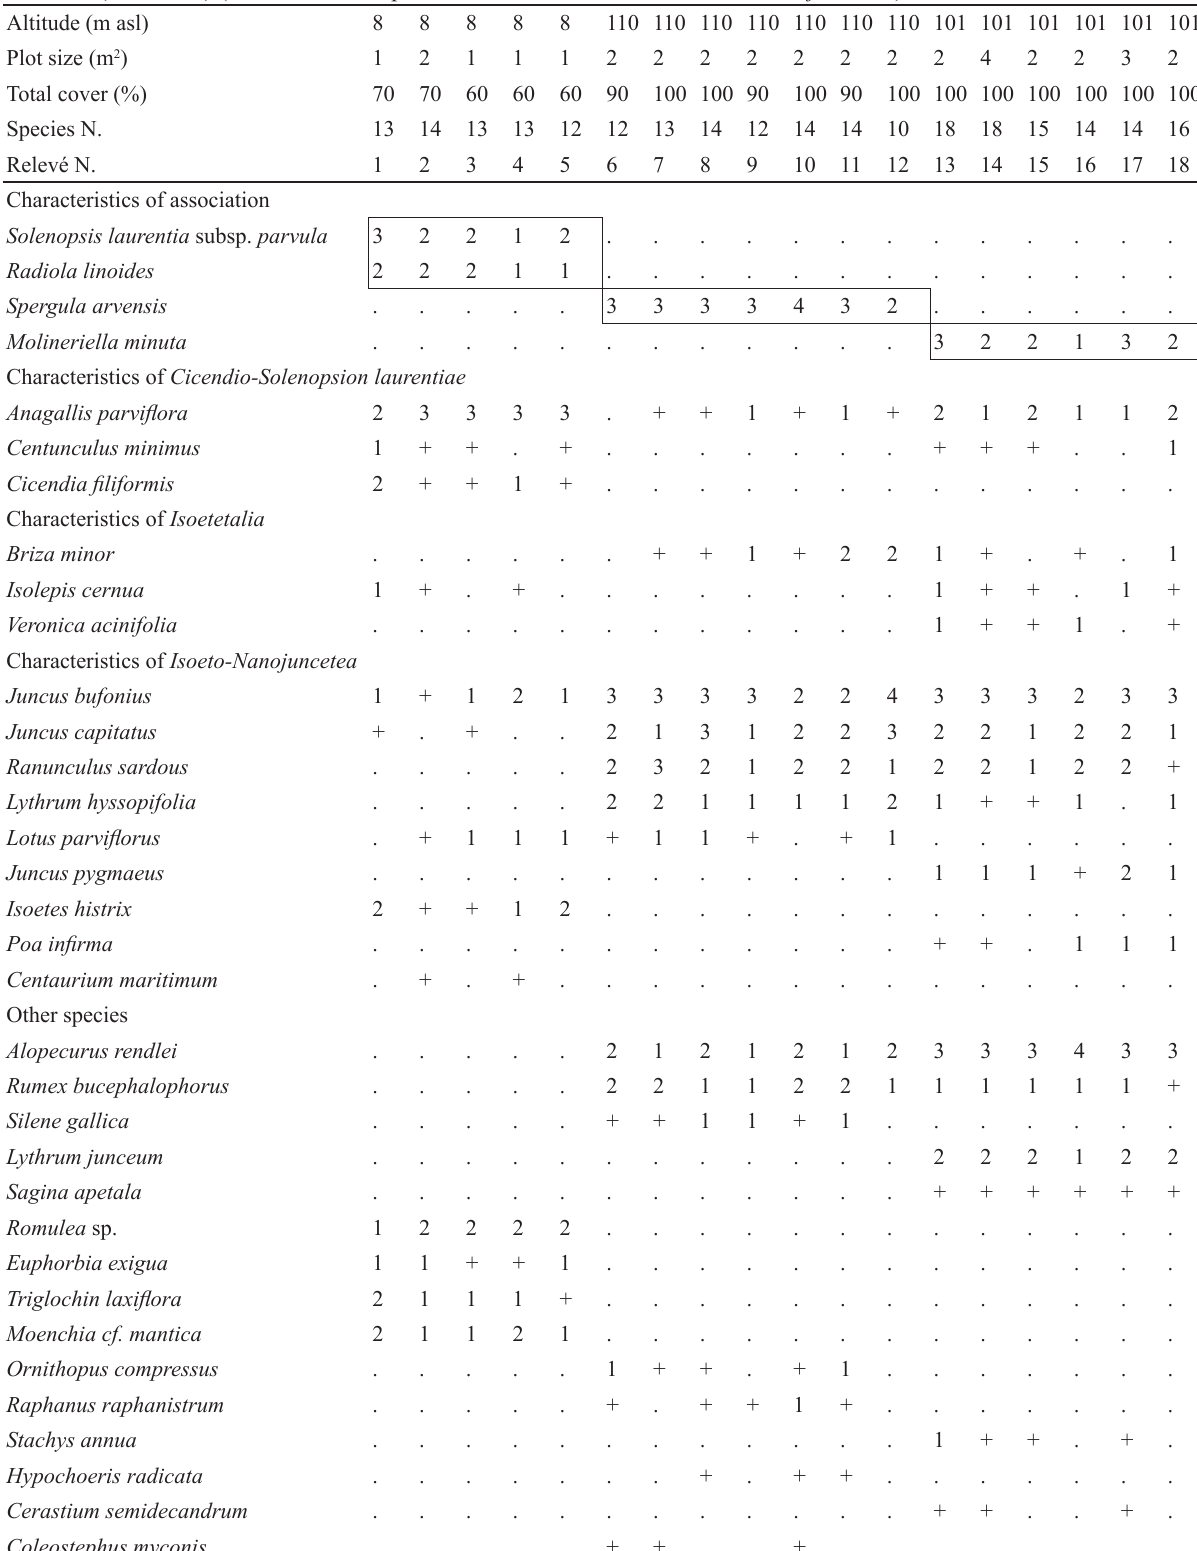
Table 7. Radiolo linoidis-Solenopsidetum parvulae ass. nova (rel. 1-5), Anagallido parviflorae-Spergularietum arvensis ass. nova (rel. 6-12), Anagallido parviflorae-Molinerielletum minutae Brullo, Scelsi, Siracusa, Tomaselli 1996 (rel. 13-18) ( Cicendio-Solenopsion laurentiae , Isoetetalia , Isoeto-Nanojuncetea ) Altitude (m asl) 8 Plot size (m 2 ) Species N. Relevé N. Characteristics of association